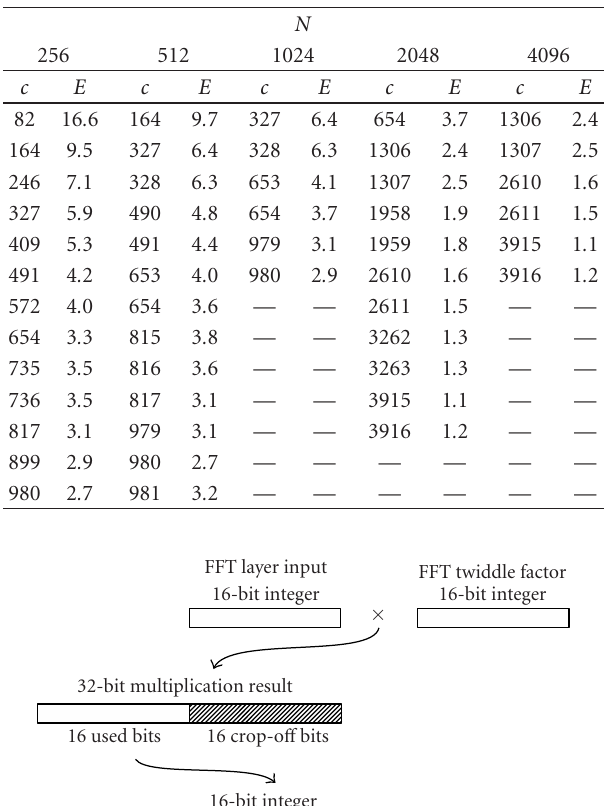
Table 1: Pairs of values c and E ( c , N ) for di ff erent FFT sizes N , the pairs are selected where E is small; the values of the function E have been multiplied by 10 3 .